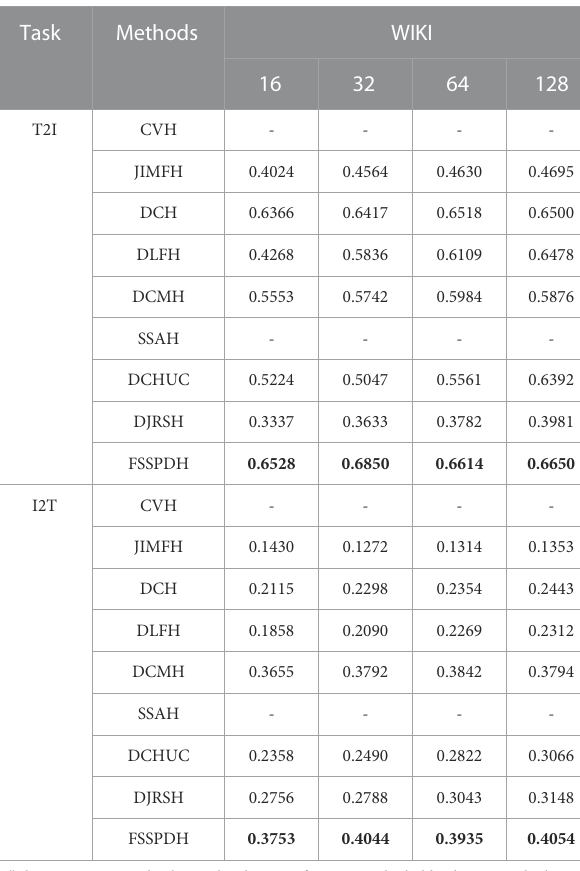
TABLE 1 The MAP values of cross-modal retrieval on WIKI